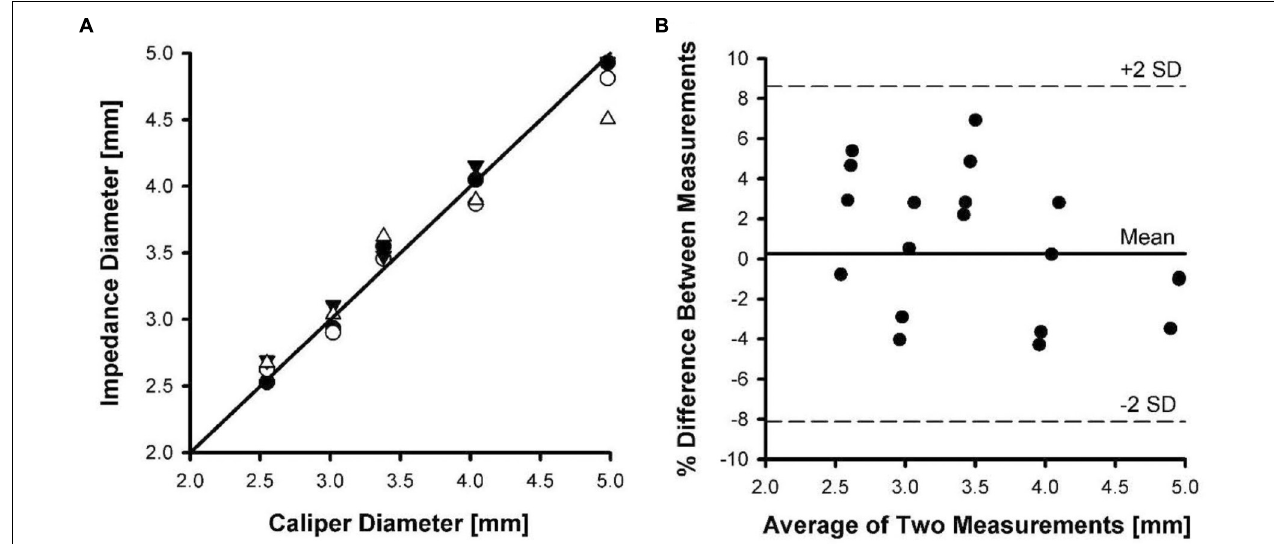
FIGURE 4 | Phantom diameter measurements determined using impedance catheters versus a caliper. Four catheters were tested in five different tubing sizes. (A) A line of identity shown between caliper diameter and impedance diameter measurements. (B) A Bland-Altman plot of mean of diameter measurements versus percent difference in measurements.